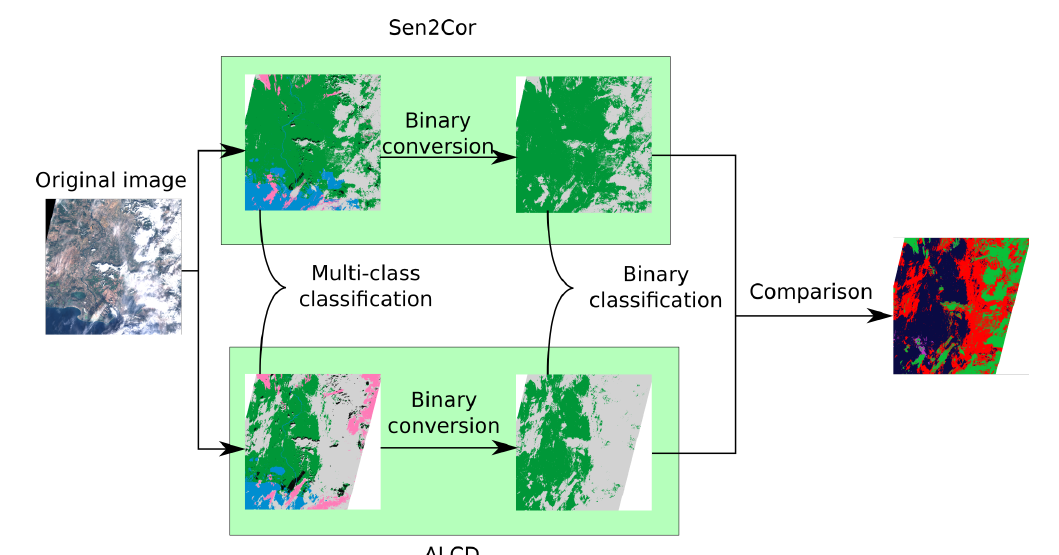
Figure 6. Procedure to derive the comparison against the reference for